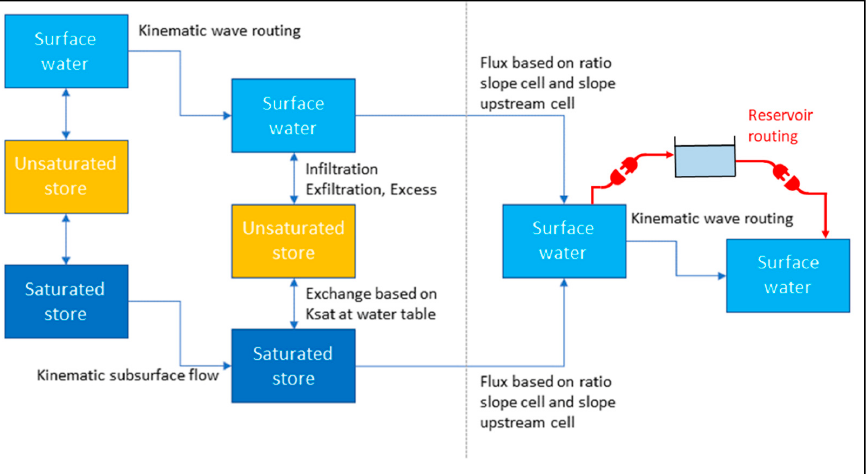
Figure 5. Scheme of wflow hydrologic model with the addition of the reservoir routing module (modified from [88]). (modified from